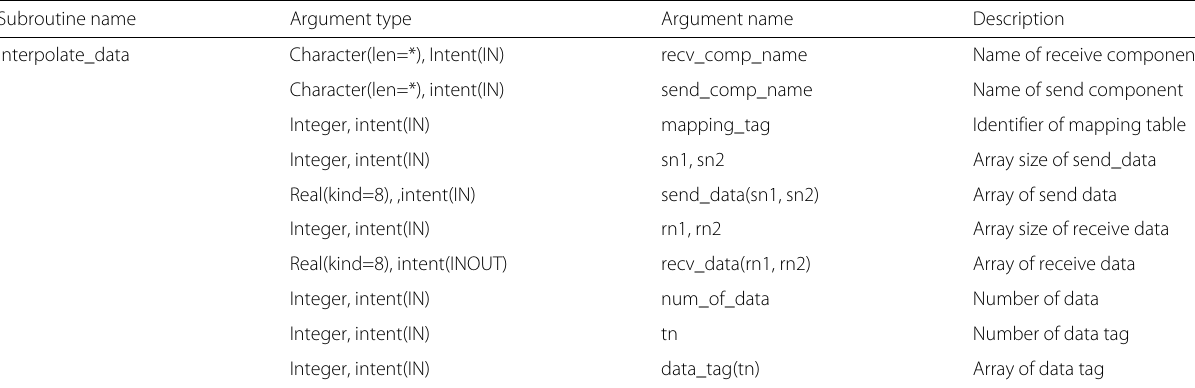
Table 2 Interface of the interpolation subroutine interpolate_data